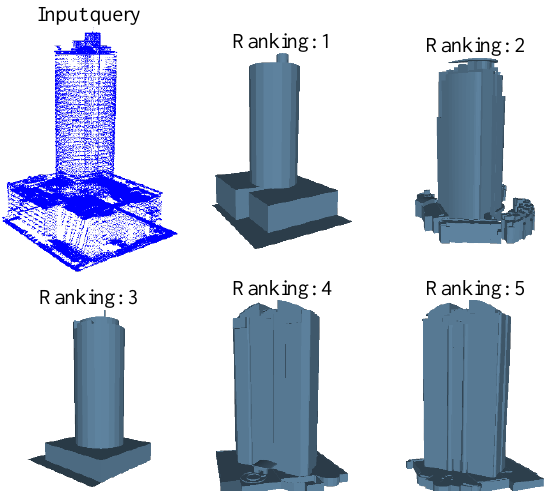
Figure 15. Retrieval results of the compared method.